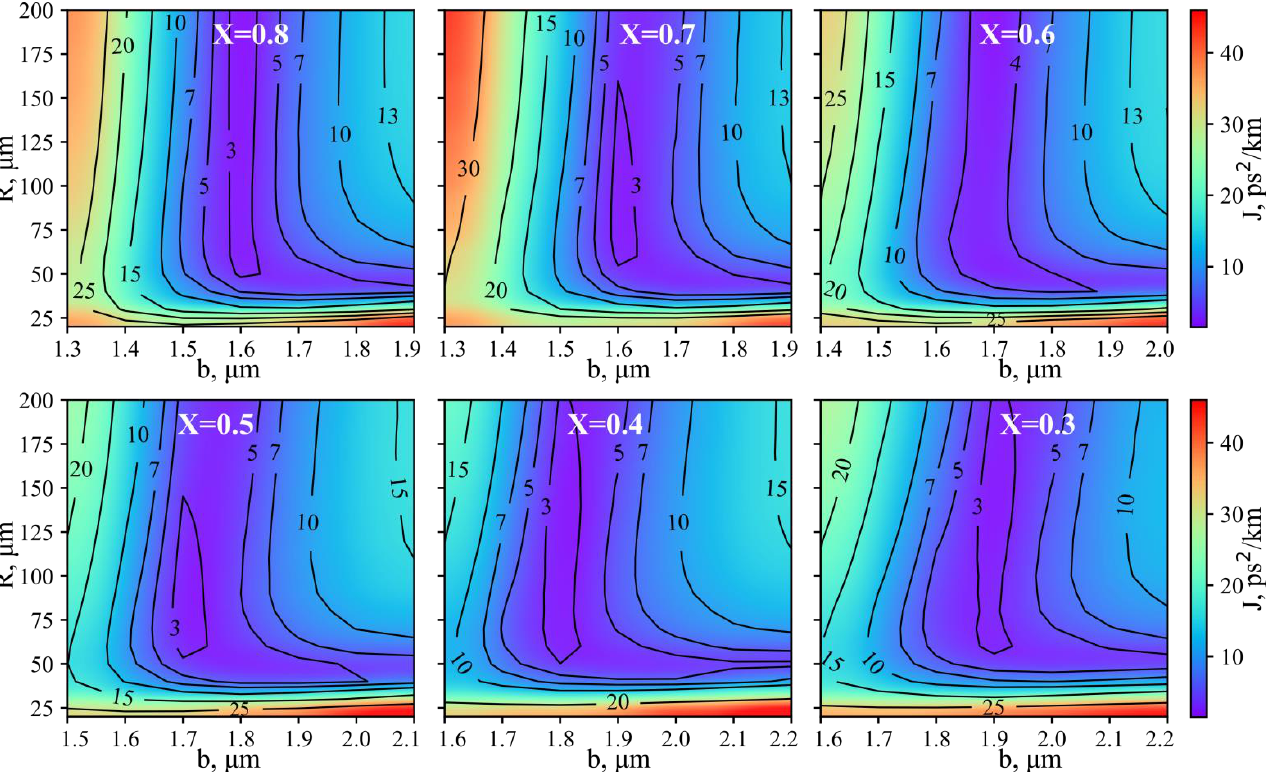
Figure 3. Calculated values of the GVD deviation function J in region I. Figures in the same row share the same colormap.